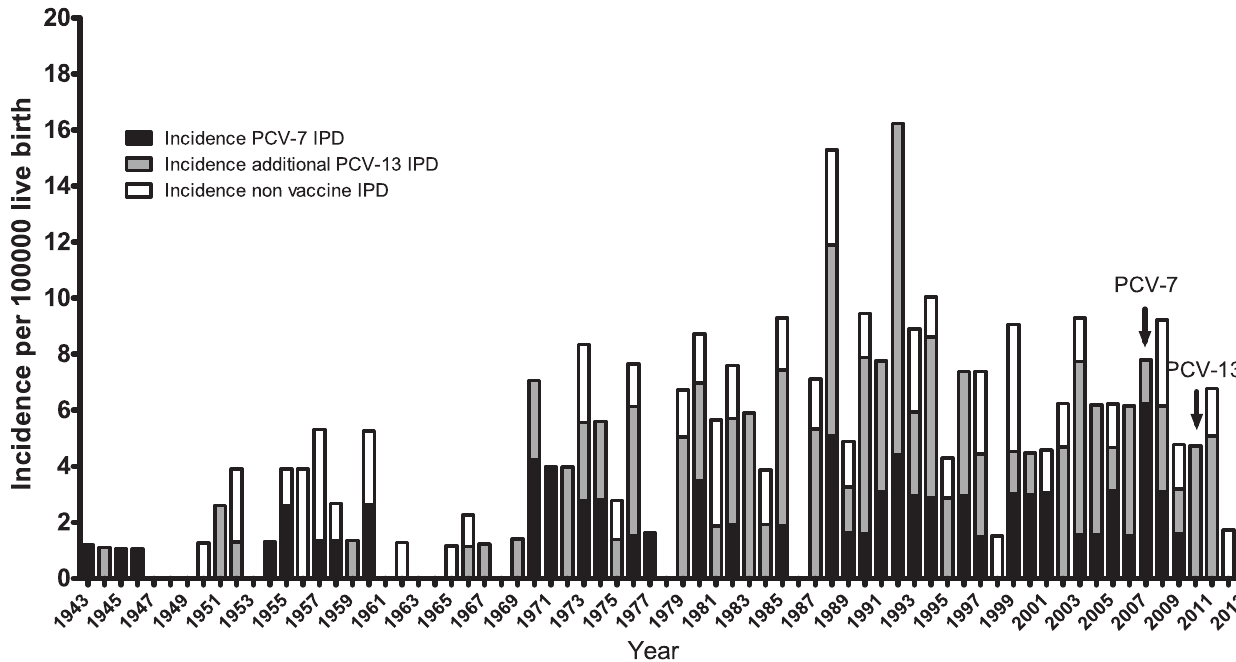
Figure 2. Incidence of IPD in infants younger than 90 days from 1943 through 2013. Black bars: serotypes included in the PCV-7. Grey bars: additional serotypes included in the PCV-13. White bars: serotypes not included in the PCV-13. PCV-7 was introduced in October 2007 and PCV- 13 was introduced in April 2010. The range of the incidence rate and Confidence Intervals (CI: 95%) for PCV-7 was from 0–6.2 (lower CI: 0–2.3; upper CI 0–16.6), for PCV-13 0–11.8 (lower CI: 0–5.9; upper CI 0–23.6) and for non-PCV-13 0–4.5 (lower CI: 0–1.5; upper CI 0–15.1).